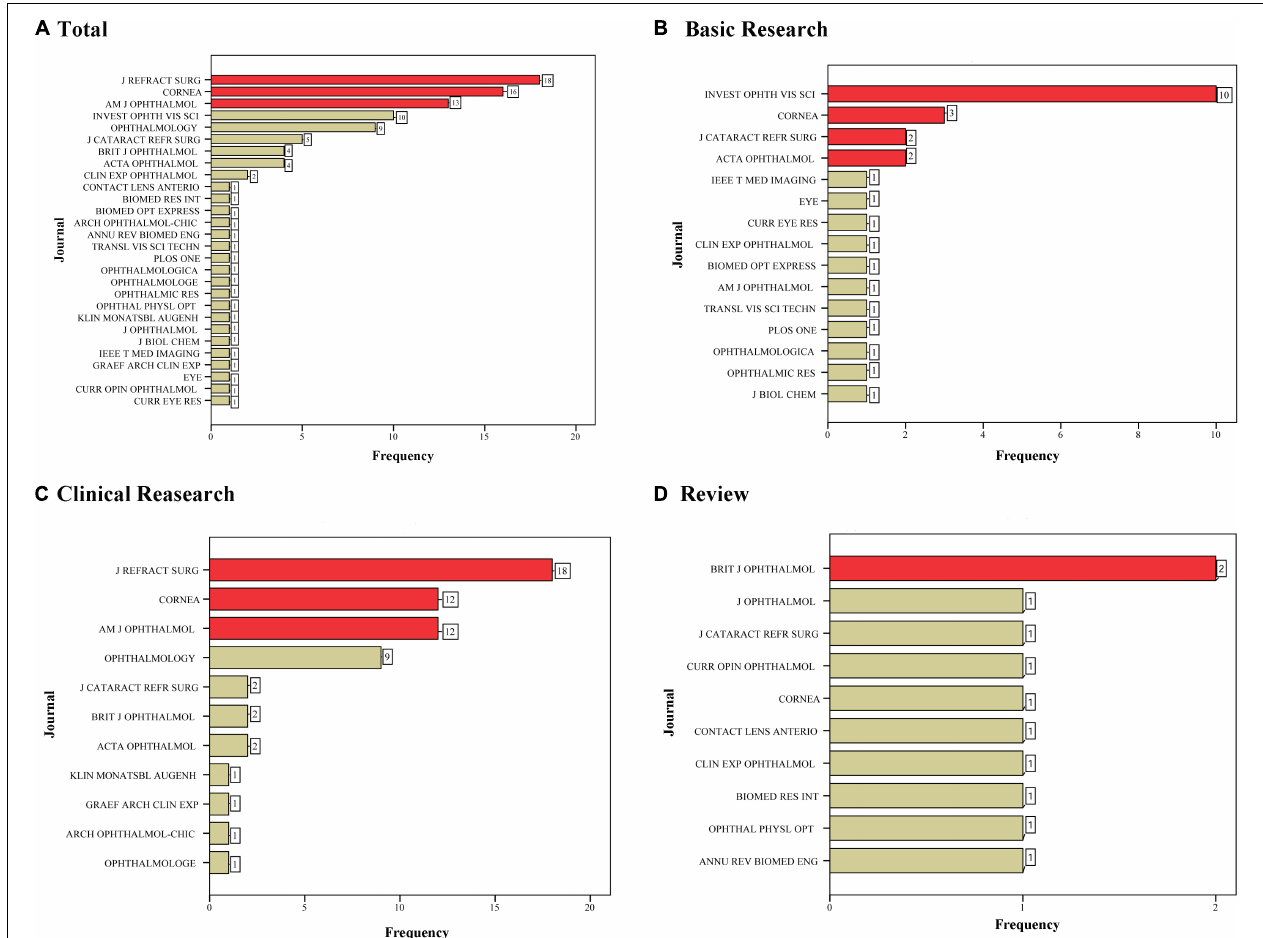
FIGURE 2 | Journals of the 100 most-cited articles were published. (A) total; (B) basic research; (C) clinical research; and (D) review.